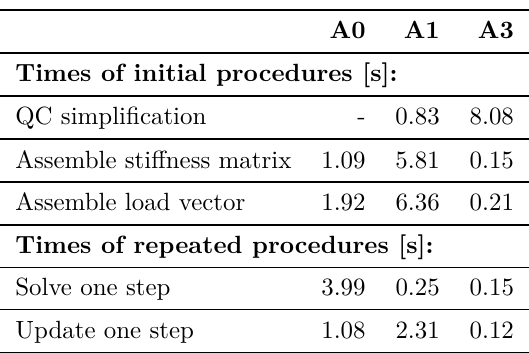
Table 2. Time consumed by individual parts of sim- ulation for various